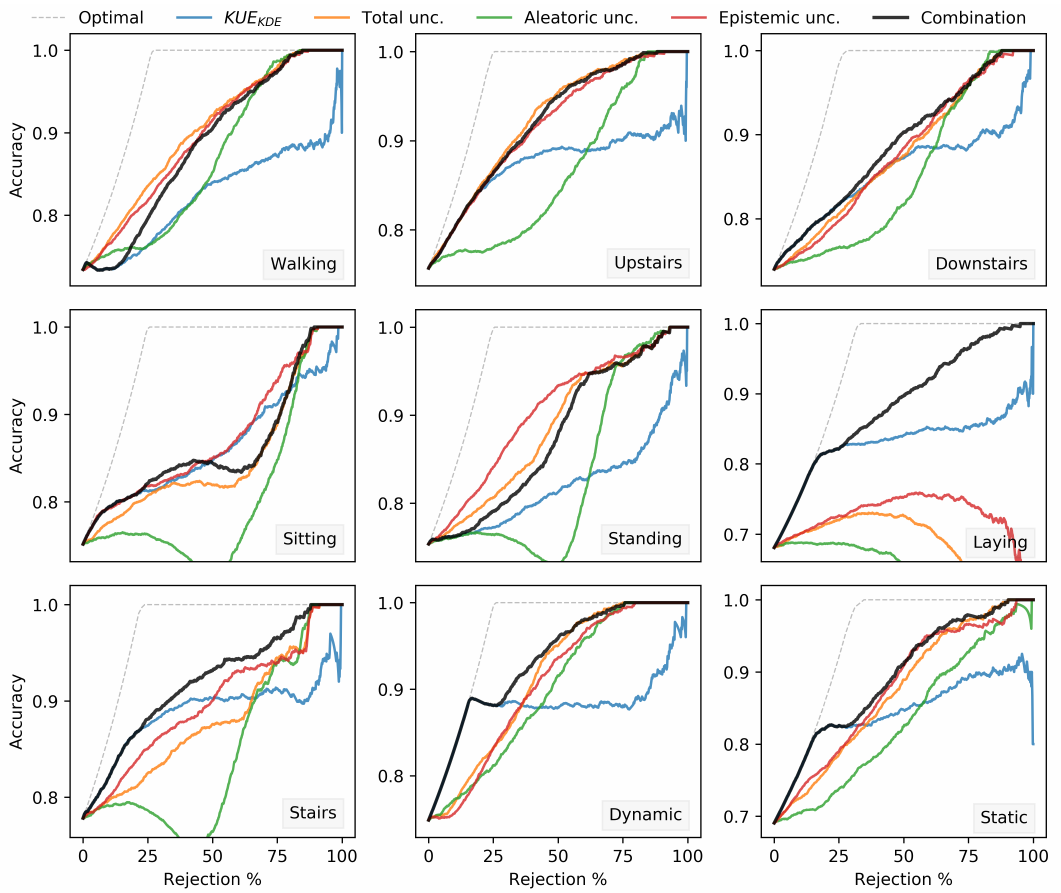
Figure A1. AR curves for aleatoric, epistemic and total uncertainty for HAR dataset. The curve for perfect rejection is included as a baseline. The name in each plot represents the activity used for each OOD input